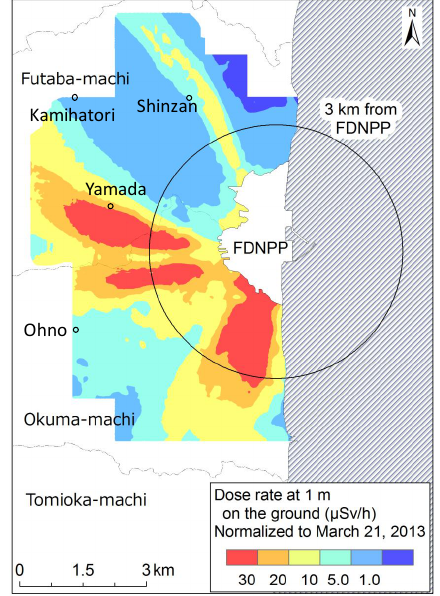
Figure 7. Spatial distributions of the air dose rate within the 5km area around FNPS1 observed by airborne survey from 28 January to 20 March 2013 (Sanada and Torii,